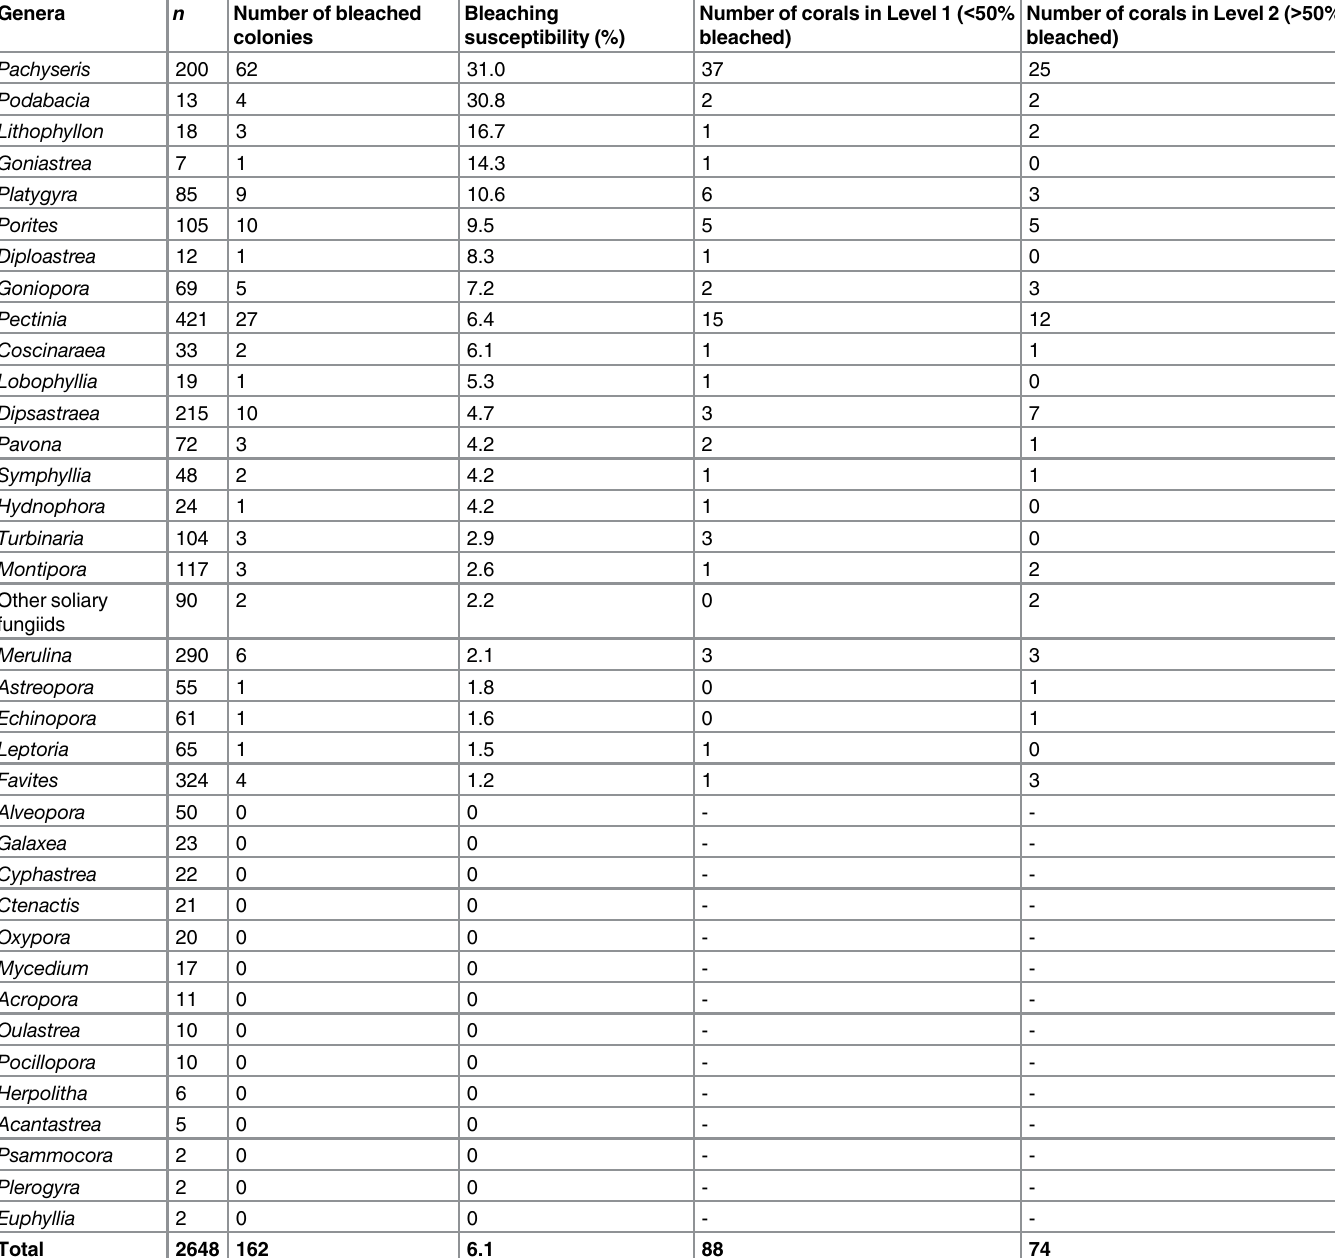
Table 1. Bleaching response of coral genera from seven study sites during a minor bleaching episode in Singapore in 2013. Genera n Number of bleached